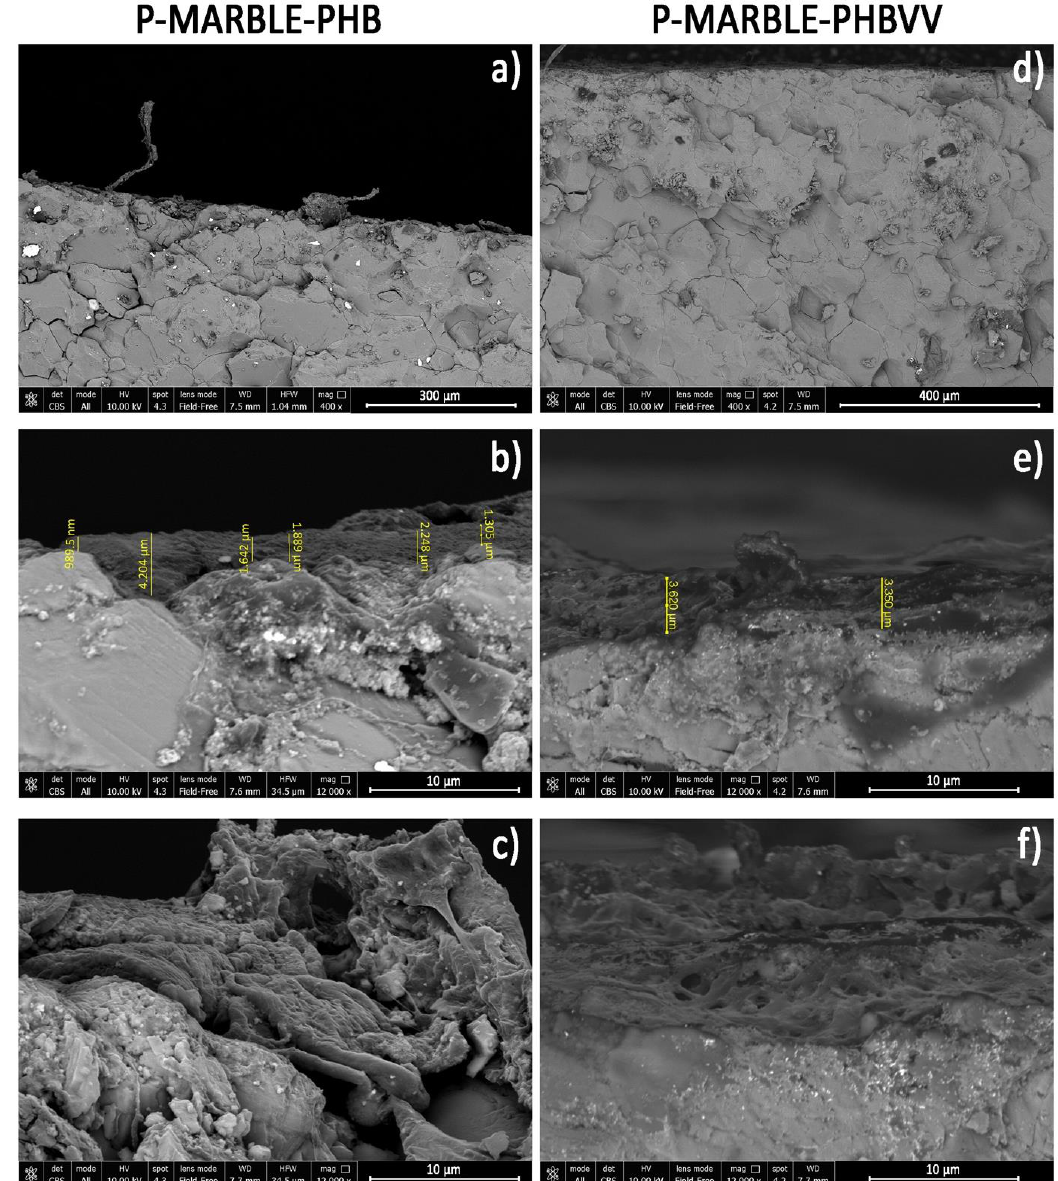
Figure 10. FEG-SEM images of marble treated: ( a – c ) with PHB-based formulation by poultice; ( d – f ) with PHBVV-based formulation by poultice.